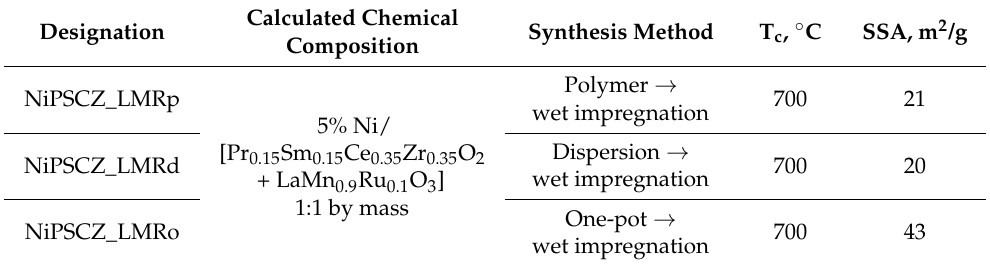
Table 1. Sample’s designation, composition, synthesis methods and SSA.